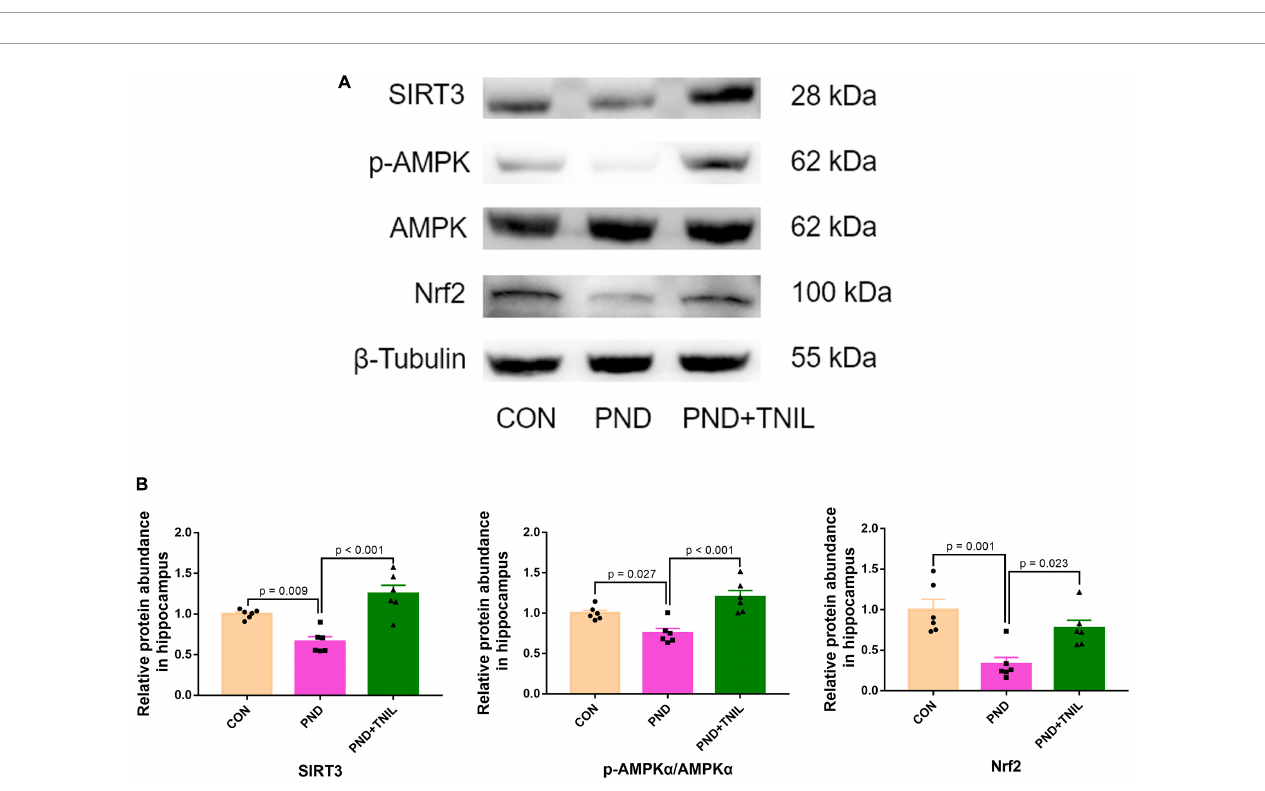
FIGURE6 Transcranial near-infrared laser activated SIRT3/AMPK/Nrf2 pathway. (A) Representative Western blots of SIRT3, p-AMPK, AMPK, and Nrf2. (B) Relative protein expression of SIRT3, p-AMPK, AMPK, and Nrf2. Data are shown as mean ± SEM ( n = 6).